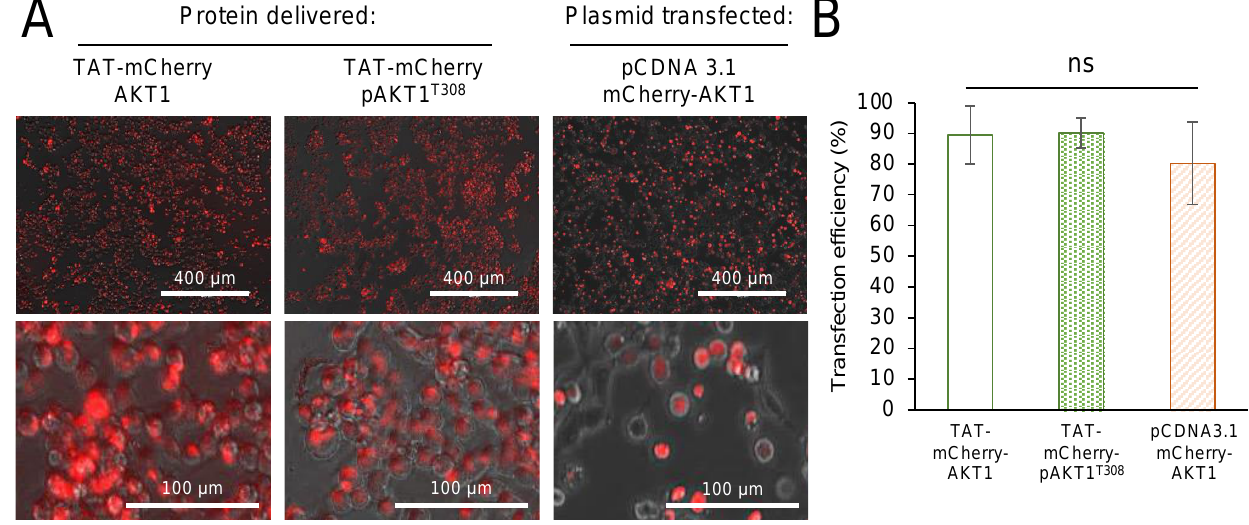
Figure 7. Delivery of TAT-mCherry-AKT1 variants compared to plasmid-based transfection efficiency of mCherry-AKT1. ( A ) Overlay of brightfield and fluorescent (excitation 531 nm, emission 593 nm) images (above) and zoomed-in images (below) of cells 24 h after incubation with TAT-mCherry-AKT1, TAT-mCherry-pAKT1 T308 , or lipofectamine mediated transfection with an mCherry-AKT1 expressing plasmid. ( B ) Quantification of delivery or transfection efficiency from three biological replicates was calculated as the ratio of transfected cells/total cells and by determining fluorescence of the mCherry-AKT1 fusion proteins in cells. Protein delivery and plasmid transfection efficiency was not significantly different. The data are based on three biological replicates, error bars show ±1 standard deviation, and significance was calculated by one-way ANOVA (ns — not significant).